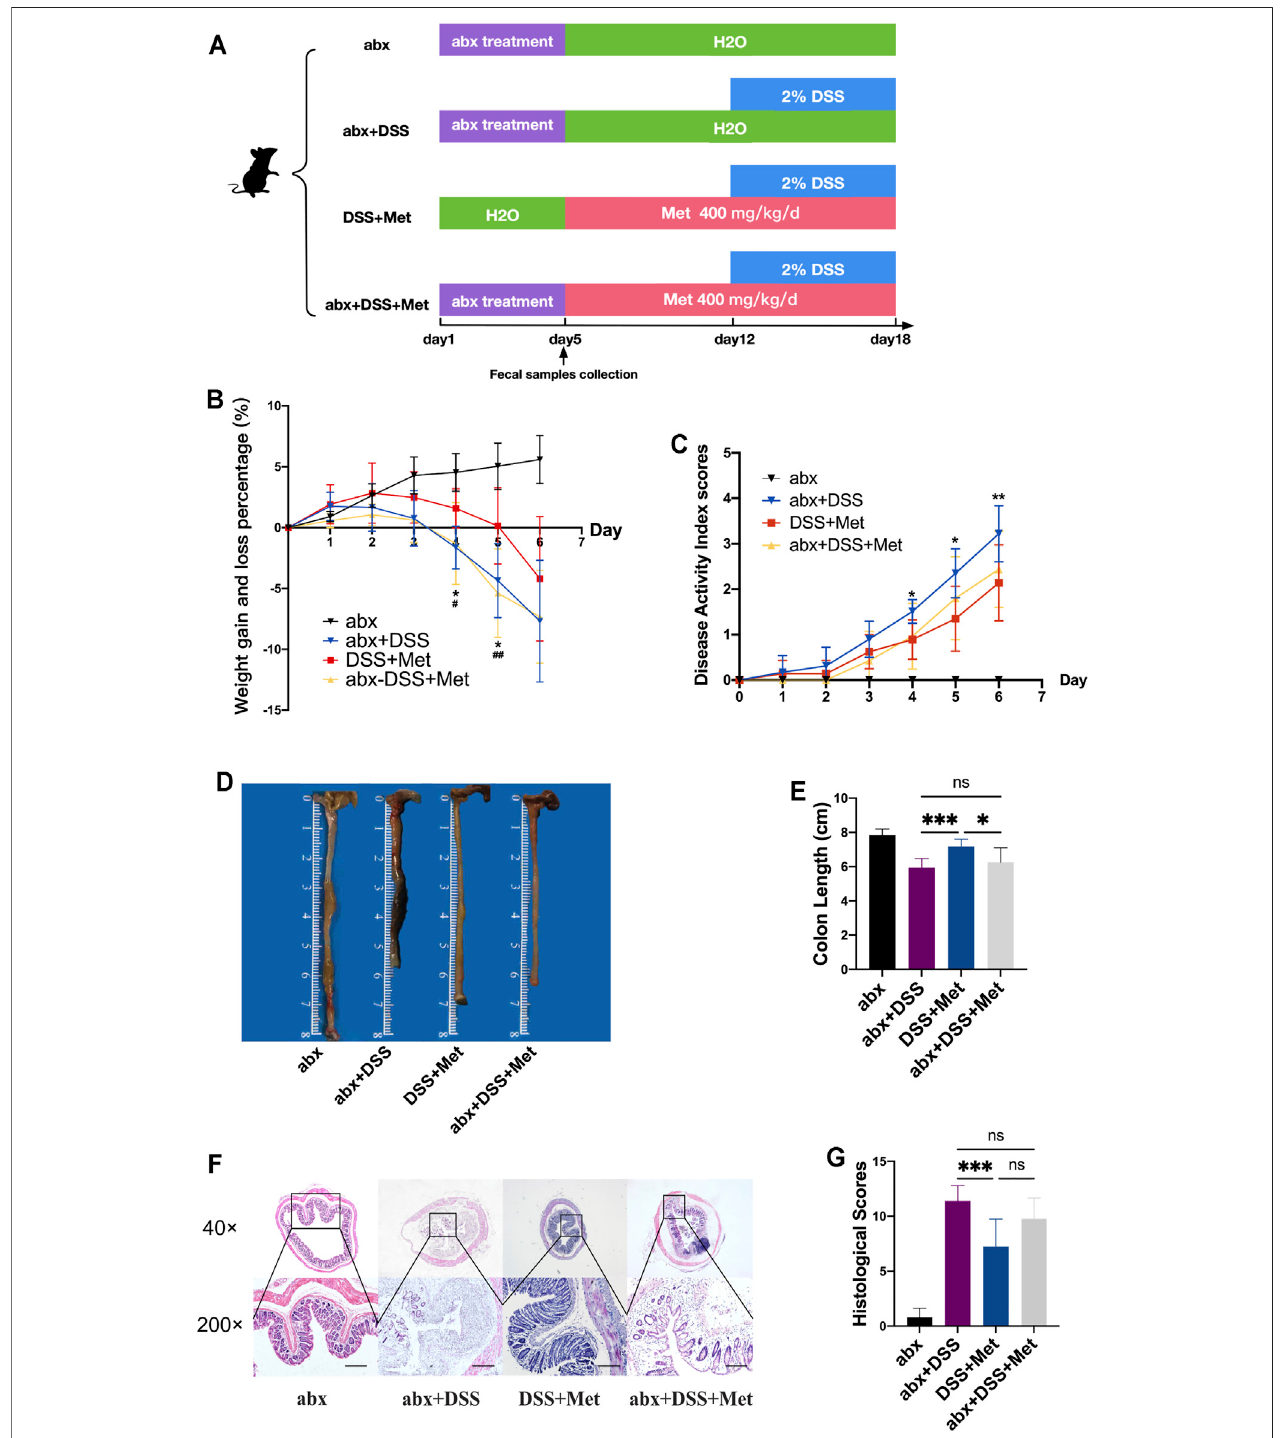
FIGURE 5 | Antibiotics abolish the anti-in fl ammatory effects of metformin. Flow chart of animal treatment (A) , weight loss and gain ( n (cid:1) 6 – 10) (B) , disease activity index (DAI) scores ( n (cid:1) 6 – 10) (C) , representative pictures of the mouse colon ( n (cid:1) 6 – 10) (D) , colon length ( n (cid:1) 6 – 10) (E) , hematoxylin and eosin (HE) staining (scale bars, 400 μ m) (F) , histological scores ( n (cid:1) 5 – 8) (G) * p < 0.05 (DSS+Met vs abx+DSS) and statistical comparison was made using an ANOVA test followed by Dunnett ’ s post- hoc tests. ** p < 0.01, *** p < 0.00, # p < 0.05 (DSS+Met vs abx+DSS+Met), ## p < 0.01.